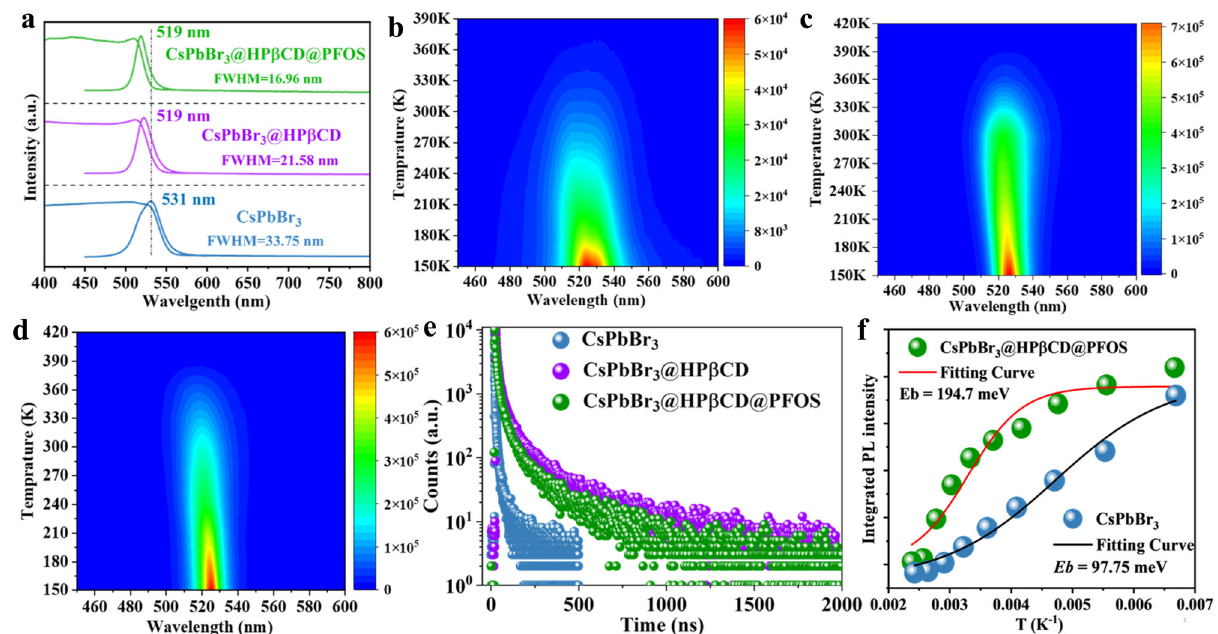
Fig. 3 | The characterization of optical property, temperature-dependent photoluminescence and exciton binding energy of different PLTs. a UV-visible absorptionandPLspectraofCsPbBr 3 ,CsPbBr 3 @HP β CDandCsPbBr 3 @HP β CD@PFOS fi bers. Temperature-dependent PL mapping of ( b ) CsPbBr